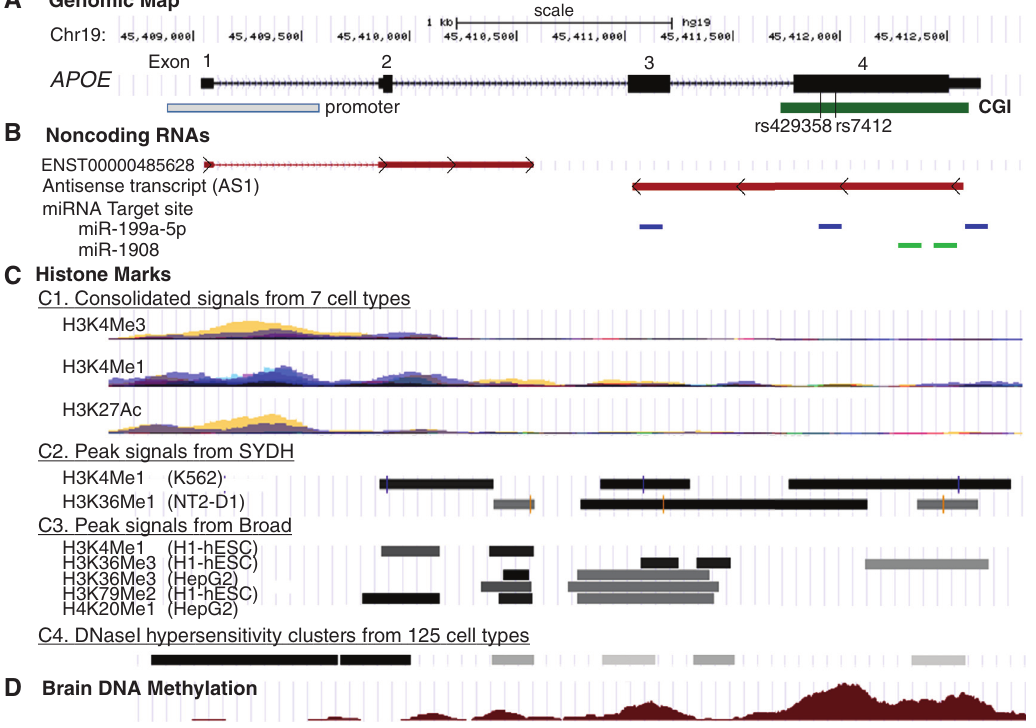
Figure 1: An overview of APOE ’s epigenetic signatures. (A) Genomic map of APOE exons, promoter, CGI, and two CpG SNPs. (B) Genomic position of noncoding RNAs. (C) Genomic position of histone marks and DNase I hypersensitivity sites from ENCODE project (47). (D) DNA methylation profiles of UCSF brain project